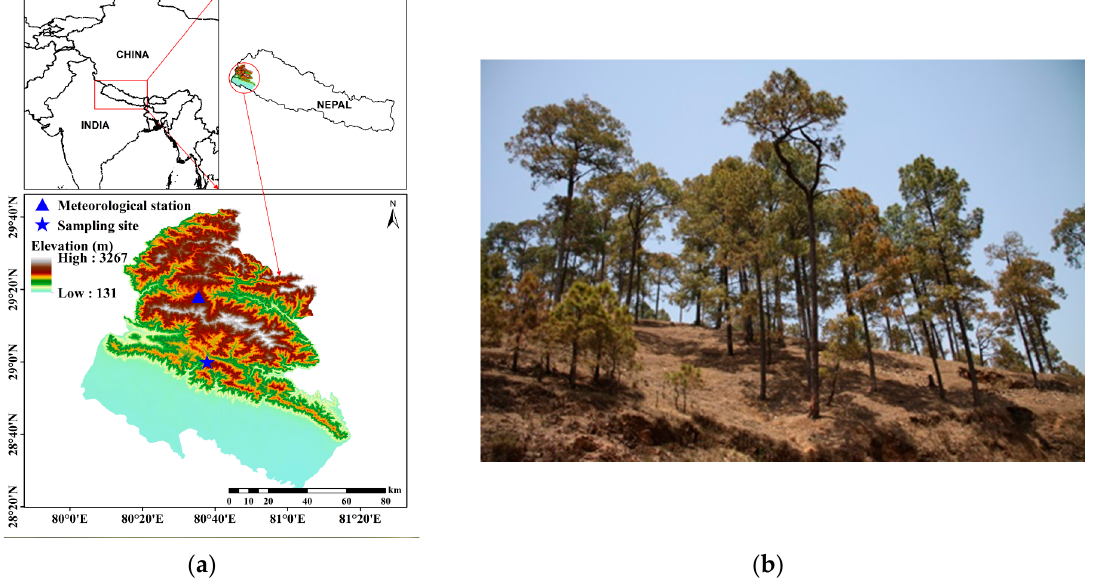
Figure 1. Location map ( a ) of the tree-ring sampling site of Chir pine ( ⋆ ) and the Dadeldhura local meteorological station ( ▲ ), located in western Nepal, and ( b ) view of the sampled site. Chir pine is widely distributed across the Himalayas (from Afghanistan to Bhutan) and can grow up to 30–40 m in height. It grows at elevations from 800 to 2100 m a.s.l. across the